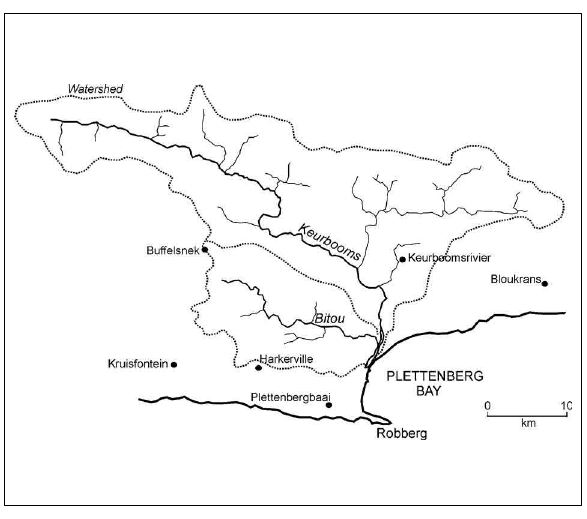
Catchment areas of the Keurbooms and Bitou Rivers. 2 The rainfall stations used in the analysis are shown. Reddering 2 calculated the tidal prism, or volume of water entering